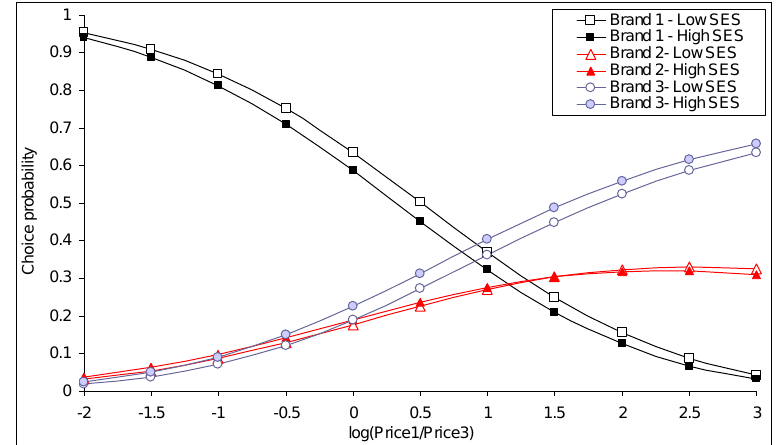
Figure 9 The impact of changes in the relative price of Brand 1 over 3 on the choice probabilities